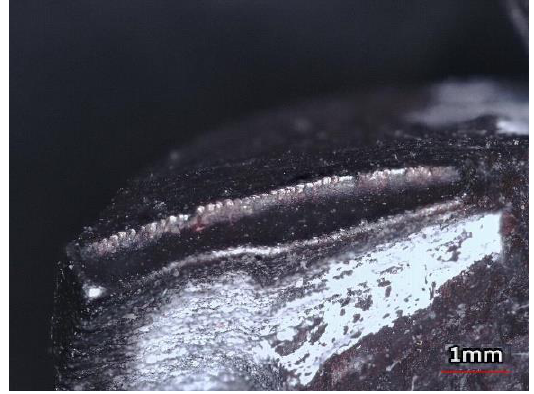
Figure 10. Rounded cutting edge of the as-fabricated tool.